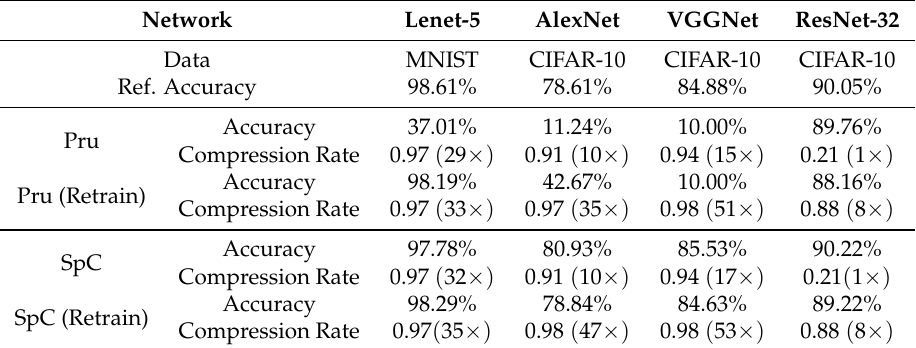
Figure 7. The effect of retraining. The maximal compression rates where our methods SpC and SpC(Retrain) achieve at least 99% of the reference prediction accuracy are indicated by vertical lines (solid: SpC, dotted: SpC(Retrain)). Retraining is indeed required for Pru since otherwise high compression rate is not possible to achieve good prediction performance. On the contrary, our method SpC without retraining can achieve high accuracy at high compression. Retraining for SpC can be considered when we aim for very high compression. Table 1. Summary of network compression results. (Pru: network pruning, SpC: our